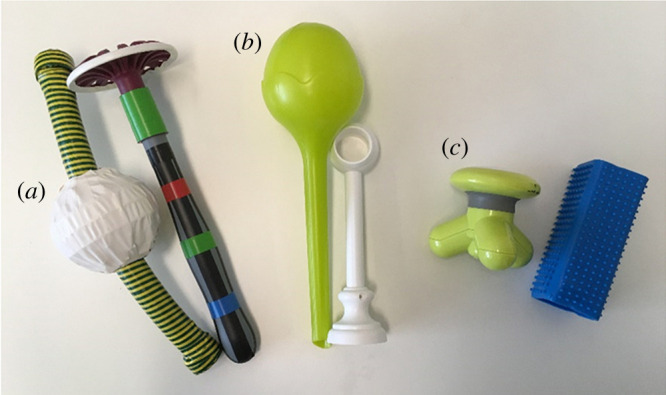
Pairs of objects used in the interactive and explicit Sefo tasks in study 3a ((a) a masher for potatoes and a ball prepared with a tube, (b) a plant watering bulb and a curtain holder, (c) a lint brush and a massage device).